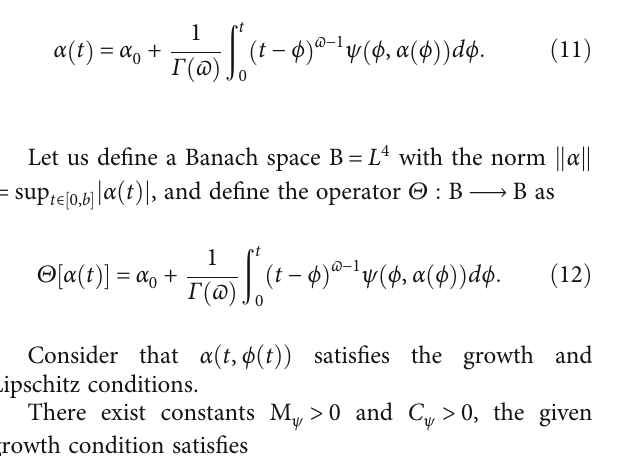
Table 1: Linear stability analysis of system (1).